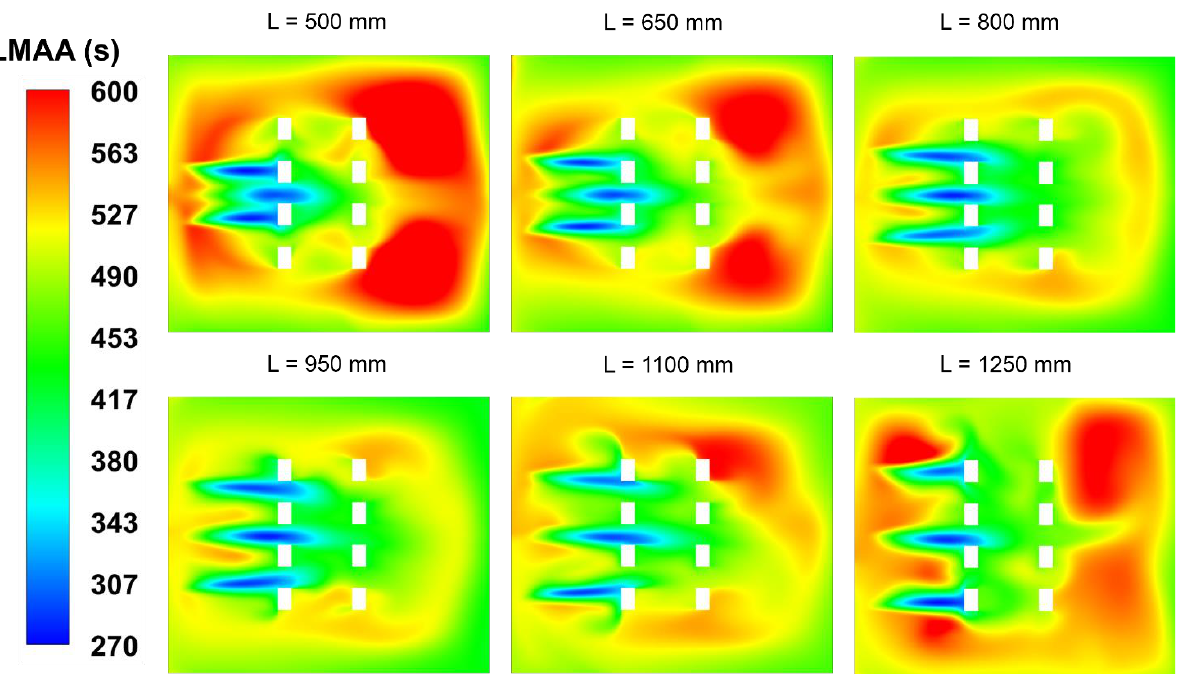
Figure 14. Contour of local mean air age in the plane z = 1.1 m with different air inlet spacings.